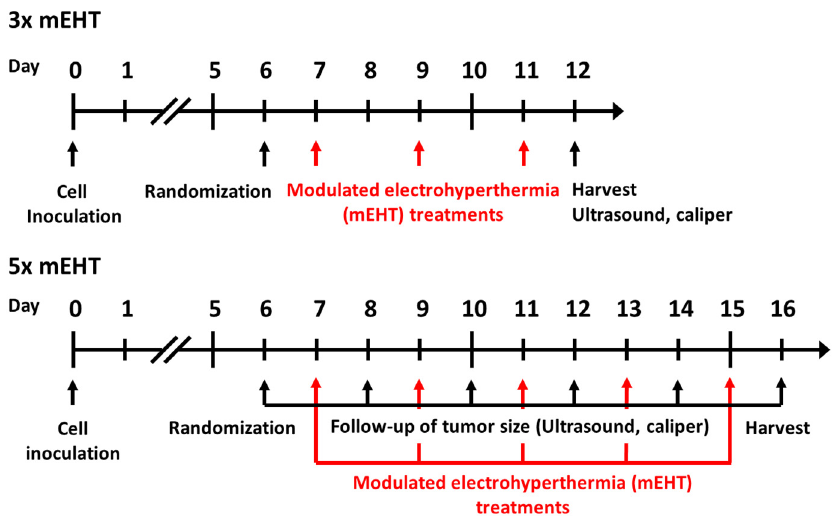
Figure 8. Timeline of in vivo experiment protocols. Cell inoculation was performed at day zero, randomization at day six in both short- and long- term experiments. Modulated electrohyperthermia treatments were performed at day 7, 9, 11 in the short and at day 7, 9, 11, 13, 15 in the long-term experiment. Ultrasound, caliper measurements were performed at day 6 and 12 in the short-term, and at day 6, 8, 10, 12, 14, 16 in the long-term experiment. Harvests were performed in the short- and long-term experiments at day 12 and 16, respectively.